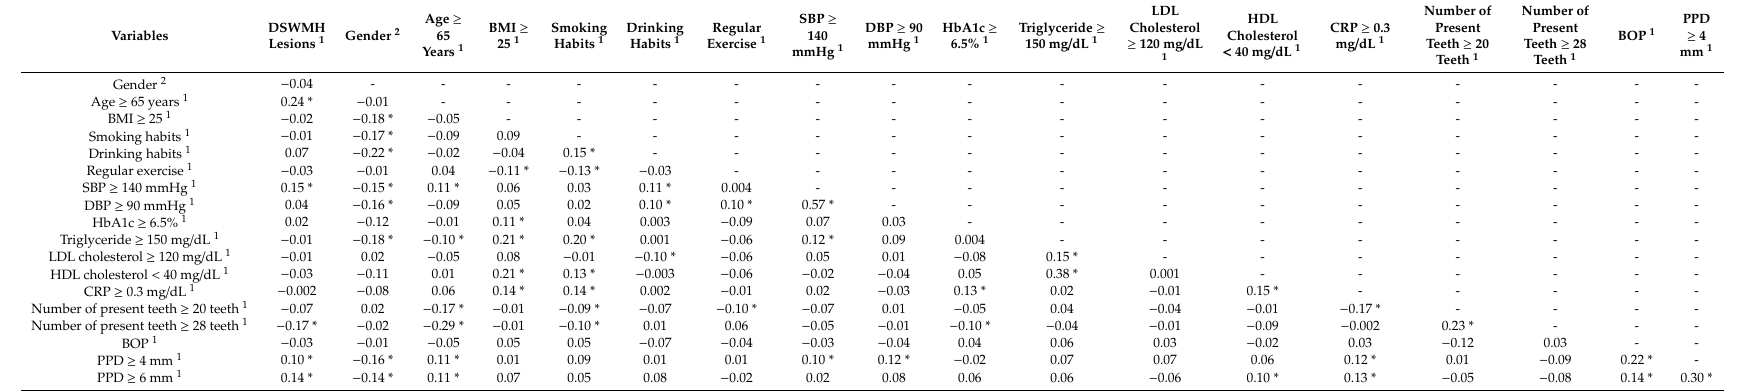
Table 3. Spearman’s correlation analysis between each